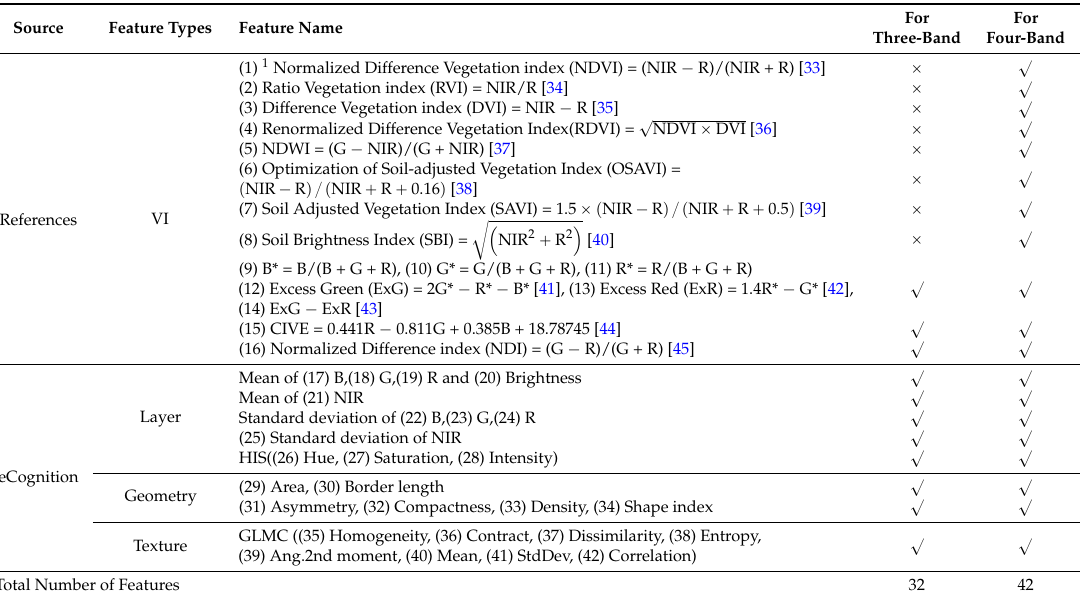
Table 2. List of object features for decision tree modeling.